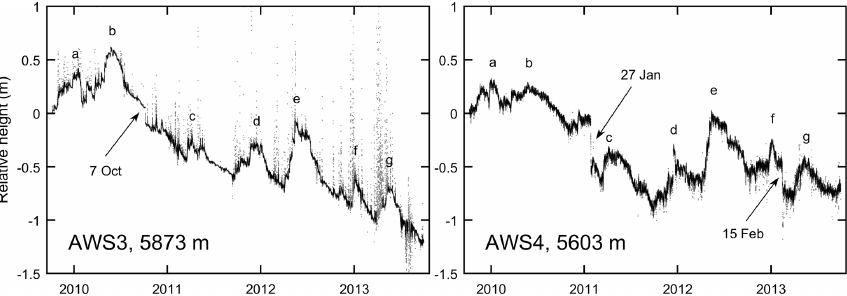
Figure 2. Surface height change at AWS3 and AWS4 relative to 8 October 2009. Grey dots are the initial half-hourly data, which are less noisy at AWS4 due to the logging interval (see text). The black line illustrates corrected data (Parameter Combination 1; see the Supplement). Entered dates indicate spurious “jumps” (see text) and letters a–g the main and consistent accumulation periods. Ticks on the x axes mark the beginning of the respective year (1 January).